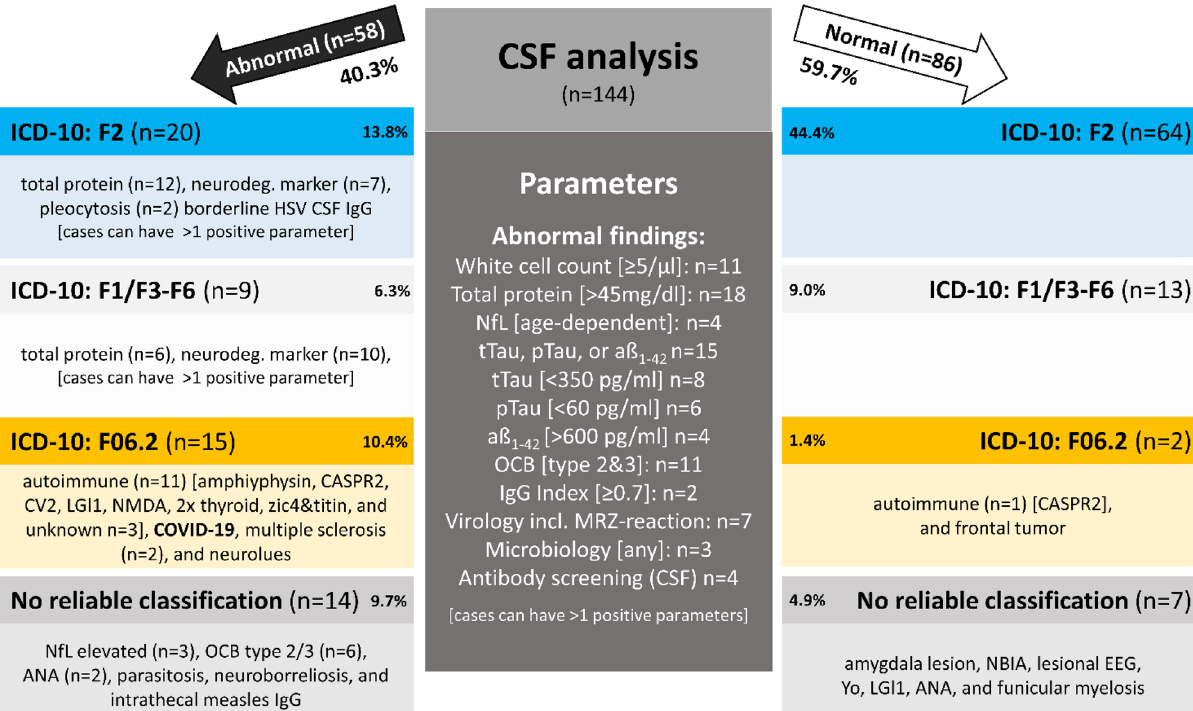
Figure 2. CSF analysis. The dichotomized categorization into abnormal (left) vs. normal (right) CSF was made according to the middle dark grey box’s criteria. Cases can have more than one positive parameter; therefore, the sum of all findings does not add up to 100% of cases. The reported proportions are percentages of the entire cohort (n = 144). Age-dependent CSF NfL cutoffs were used according to Yilmaz 28 (see also Supplementary Table 1). All cases were then analyzed using further examination results described in the operationalized group assignment procedure (see Fig. 1 for details). Any abnormal CSF finding (%) Age at onset